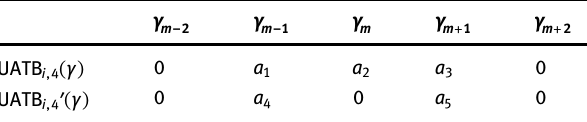
Table 1: The values of UATB i ,4 and UATB′ i ,4 at di ff erent node